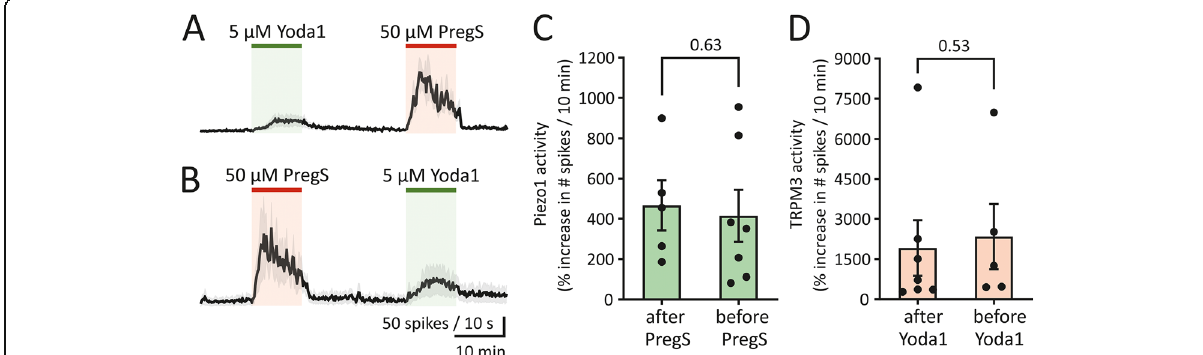
Fig. 2 Activation of Piezo1 channels has no impact on increased nociceptive firing during PregS application. ( A ) Time course of MUA in meningeal nerves of female mice when first 5 μ M Yoda1 and then 50 μ M PregS was applied (mean ± SEM, n = 7). (B) Time course of MUA in female mice when first 50 μ M PregS and then 5 μ M Yoda1 was applied (mean ± SEM, n = 5). (C) Histograms show the percentage of increased nociceptive firing in females during 10-min recordings following 50 μ M PregS application when administered before (mean ± SEM, n = 5) and after 5 μ M Yoda1 application (mean± SEM, n = 7). Notice that there is no difference in the proportion of increased nociceptive firing between the different orders of drug application ( p = 0.63, Mann – Whitney U test). (D) Histograms show the percentage of increased nociceptive firing in females during 10-min recordings following 5 μ M Yoda1 application when administered before (mean ± SEM, n = 7) and after 50 μ M PregS application (mean ± SEM, n = 5). Notice there is no difference in the fraction of increased nociceptive firing between the different orders of